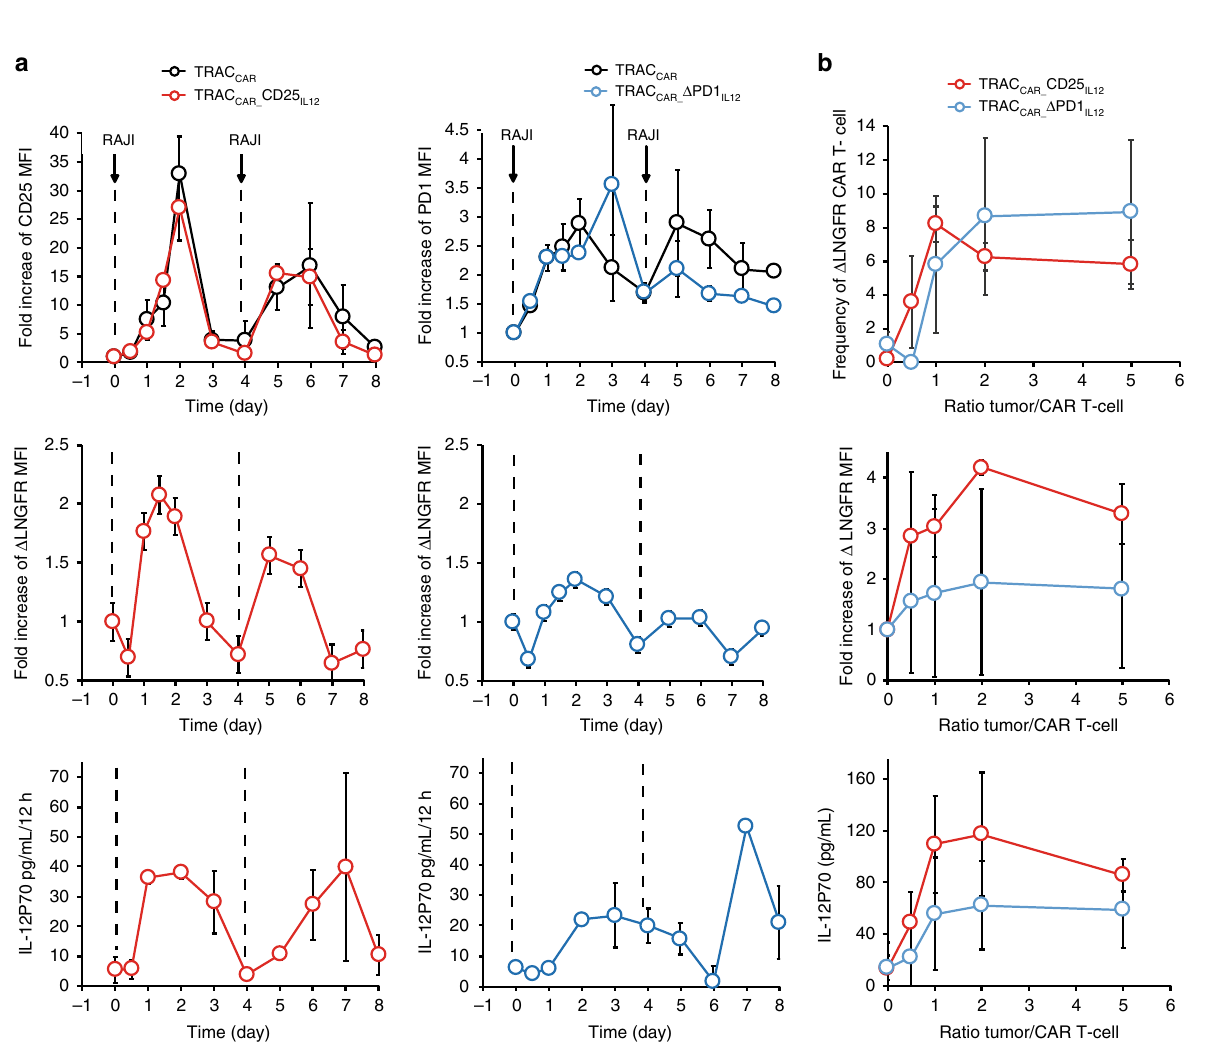
Fig. 4 The secretion of IL-12P70 by TRAC CAR T cells is regulated by tumor cell engagement in vitro. a Kinetics of CD25 and PD1 expression (top), Δ LNGFR expression (middle), and IL-12P70 secretion (bottom panel) in puri fi ed TRAC CAR T cells after two consecutive tumor cells challenges. TRAC CAR T cells were activated by RAJI cells at day 0 and day 4 and analyzed by fl ow cytometry for 8 days. IL-12P70 secreted in cell culture supernatants was quanti fi ed by ELISA and plotted as a function of time. The arrows indicate the times of tumor cell addition. The data shown represent the average + / − standard deviation of two experiments performed with cells from two different donors. b Changes in Δ LNGFR reporter expression and IL-12P70 secretion as a function of tumor cell concentration. Engineered TRAC CAR T cells were activated by different quantities of RAJI cells for 48 h. Supernatants were used to quantify IL-12P70 via ELISA assays and cells were analyzed by fl ow cytometry to evaluate the frequency of Δ LNGFR + cells, as well as its mean fl uorescence intensity. Values are plotted as a function of the tumor cell to TRAC + / − standard deviation CAR T cell ratio. The data shown are the average of three experiments performed with cells from three different donors. Source data are provided as a Source Data fi